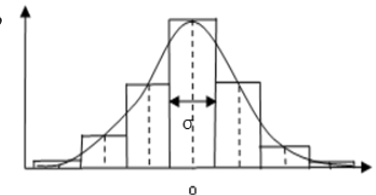
Figure 2. Typical discretized graph of the probability distribution of the wind forecast error. Derivation of the scenario probability for the wind power output model can accu- rately reflect the wind power output in each time slot.